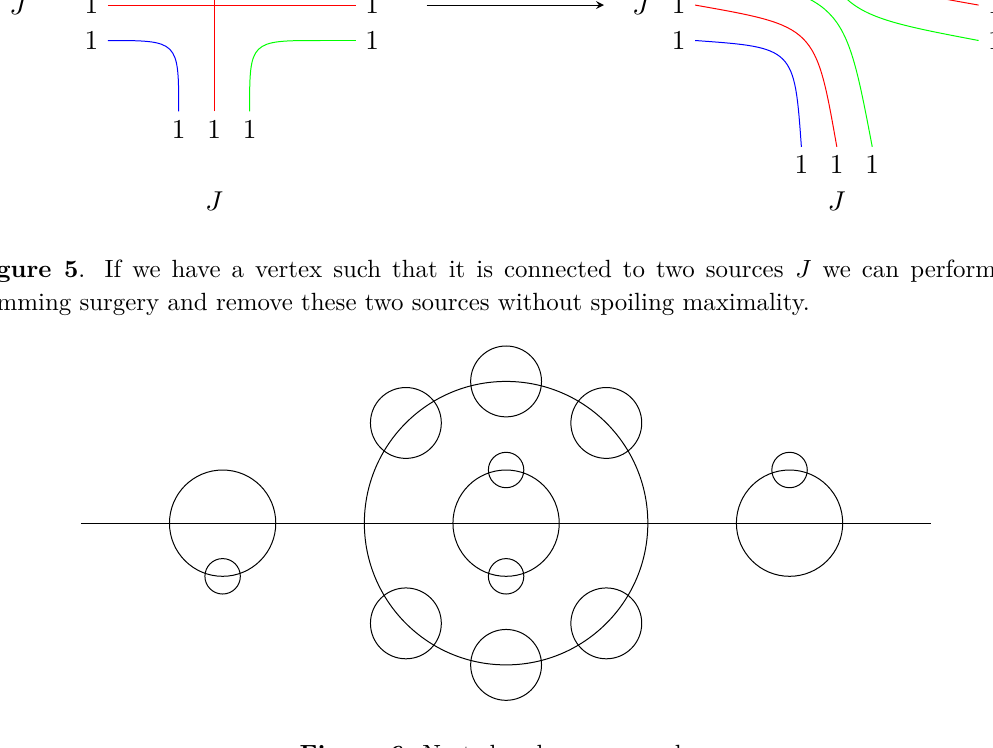
Figure 6 . Nested melons on an